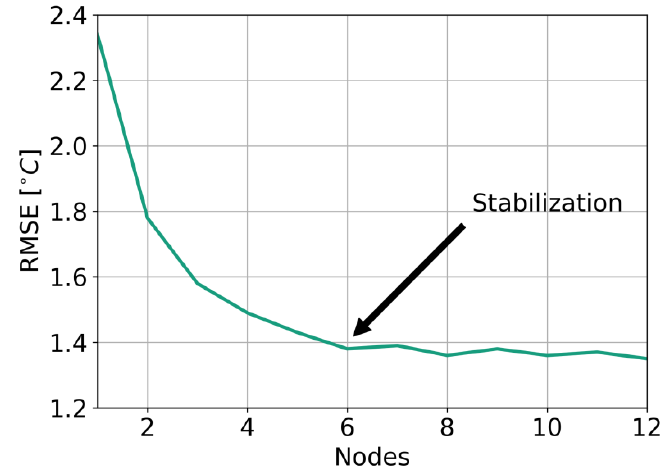
Figure 15. Root mean squared error (RMSE) as a function of the number of nodes of the heat storage discretization.